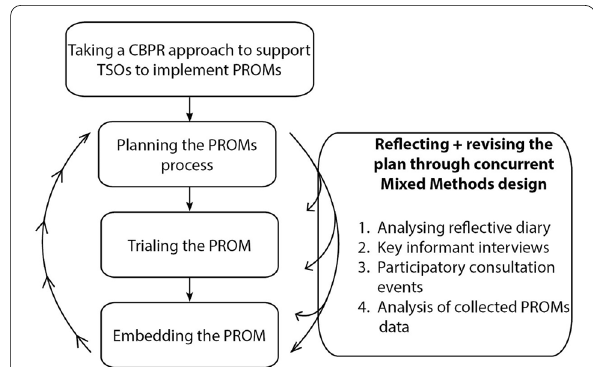
Fig. 1 Diagram documenting the Community-Based Participatory Research